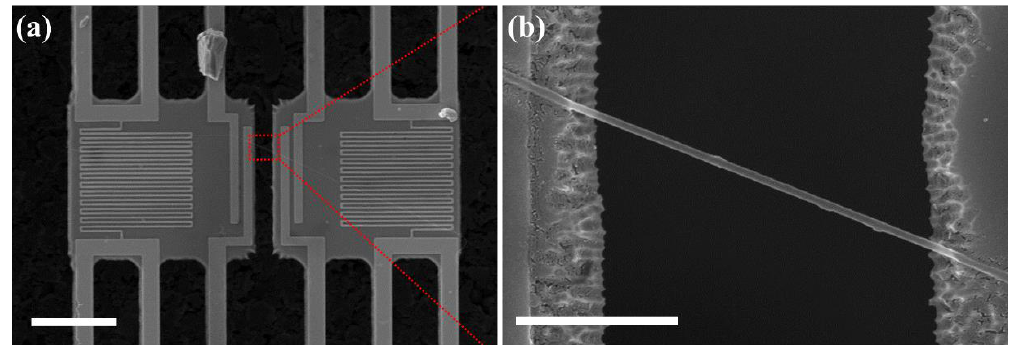
Figure 2. SEM images of the individual electrospun nylon 66 NF assembled on the suspended micro-device. ( a ) The central region of the suspended micro-device, where the suspended membranes and the NF are located. The scale bar is 20 μm. ( b ) Enlarged SEM image of the part of the NF that bridges the two suspended membranes. The scale bar indicates 2 μm.